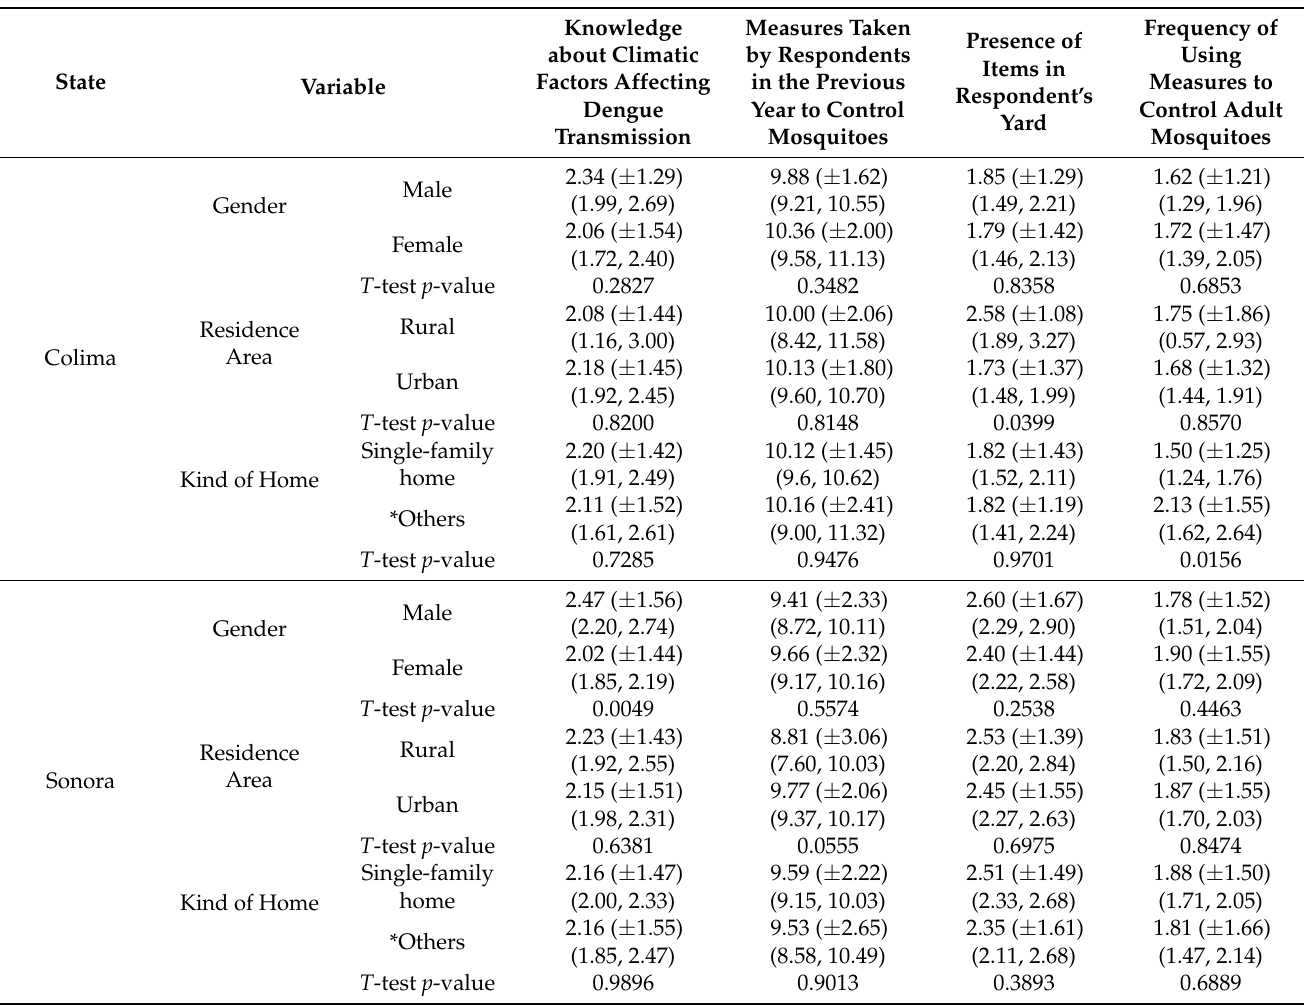
Table 2. Knowledge about factors associated with mosquito transmission, prevention, and control for different socio-economic